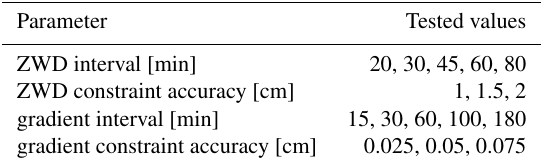
Table 2. Tested values of the parametrization of the tropospheric estimates.